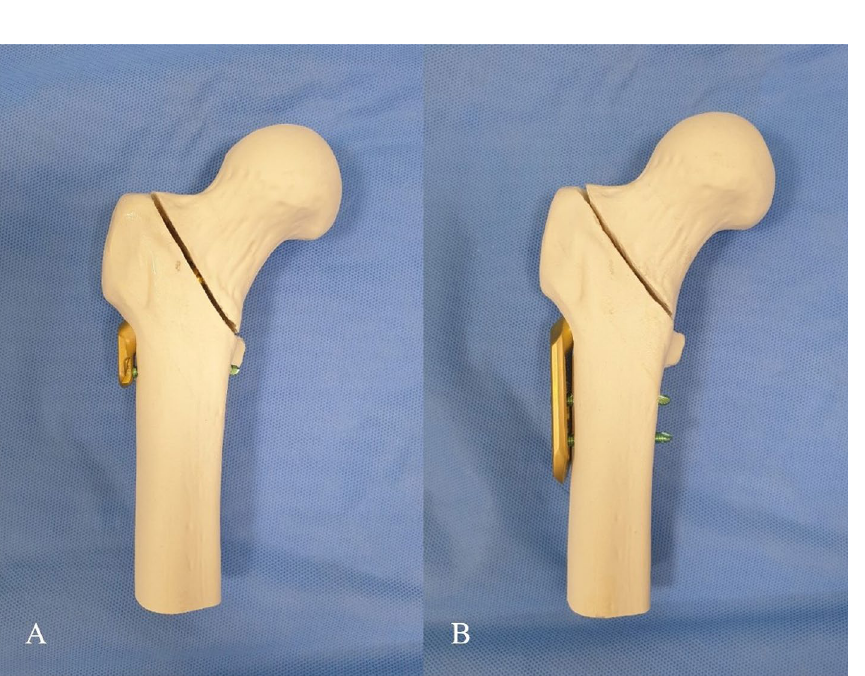
Figure 2. Each specimens in FNS group ( a ) and DHS group ( b